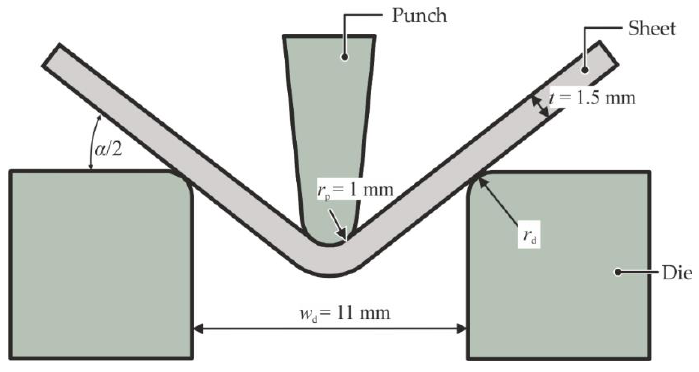
Figure 8. Air-bending process.